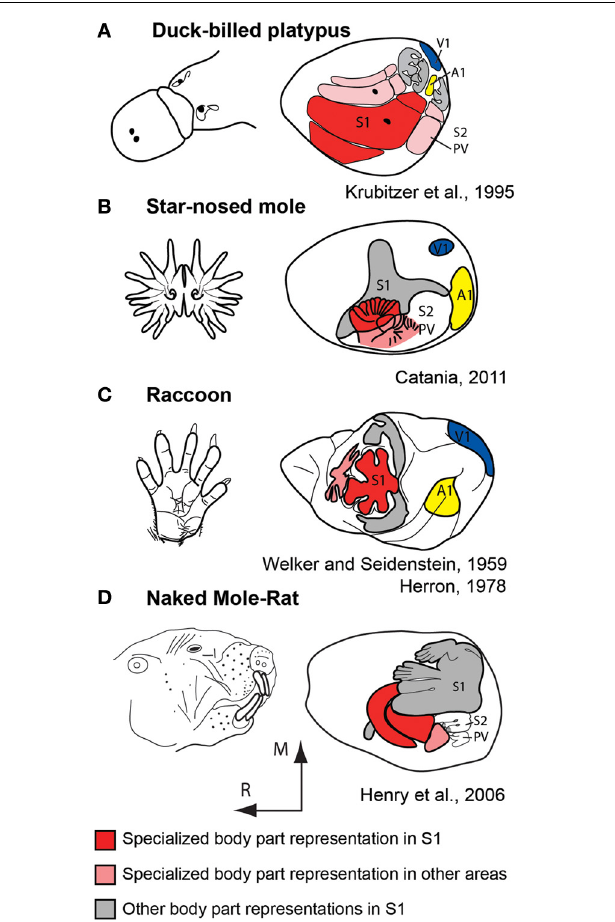
FIGURE 7 | Examples of extreme cortical magnification of behaviorally relevant effectors for somatosensory cortex of the duck-billed platypus (A), star-nosed mole (B), raccoon (C), and naked mole-rat (D). Although the specialized morphological structure and associated sensory receptor arrays are on different body parts, the same principle of magnification in the neocortex is observed. These figures are modified from Krubitzer et al. (1995) (A) ; Catania (2011) (B) ; Welker and Seidenstein (1959) and Herron (1978) (C) ; Henry et al. (2006) (D) . Conventions as in previous